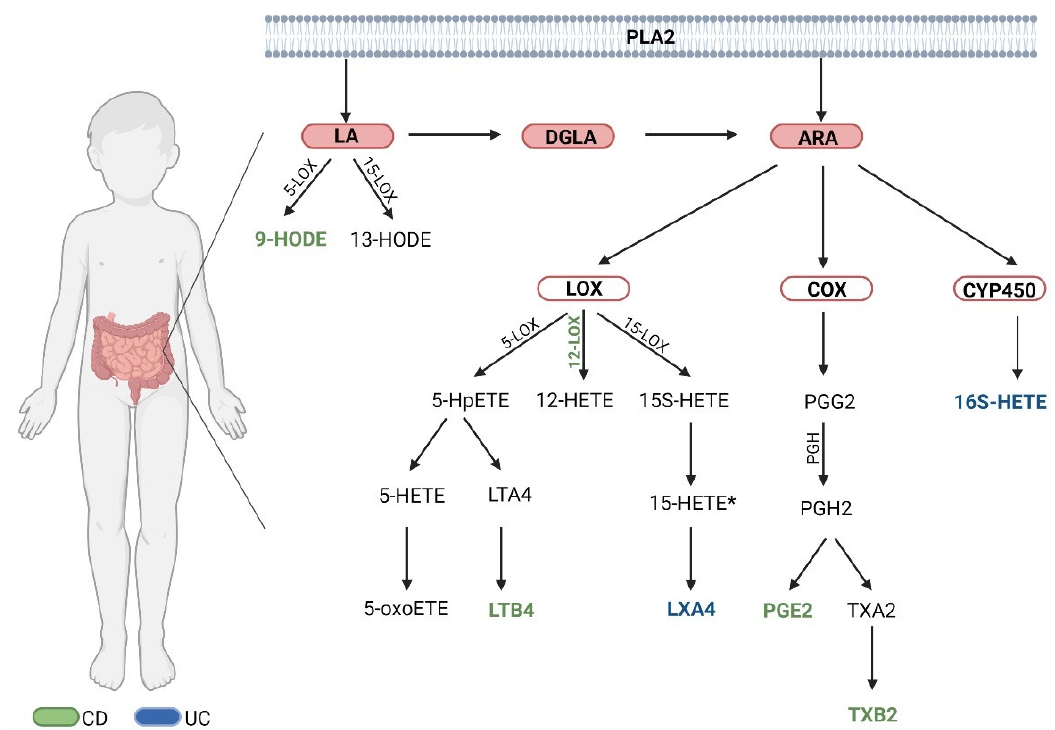
Figure 1. Synthesis of HETE and HODE acids analyzed in the study. PLA2–Phospholipase A2; LA– Linoleic acid; DGLA–Dihomo-γ-linolenic acid; ARA–Arachidonic acid; Green font–meaning in CD; Blue font–meaning in UC; * —significant difference between CD and UC (total); Created with BioRender.com (accessed on 1 January 2022)